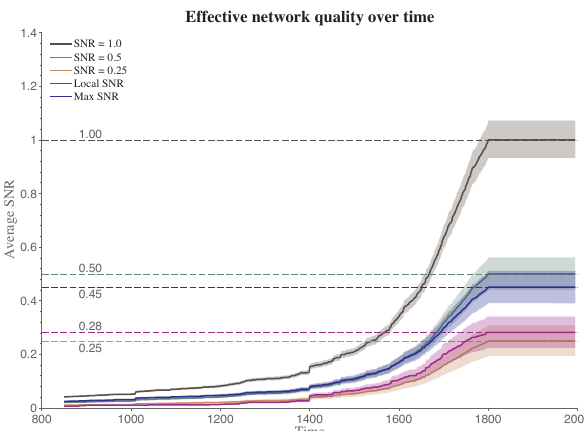
Fig. 4. Effective network quality expressed as SNR (Eq. 2) for ide- alized pseudoproxy networks and observed networks. For the ob- served SNRs, we consider two possible scenarios as described in Sect. 2.1. Shaded areas correspond to the 2.5–97.5 percentile inter- val, providing a complete picture of effective SNR across the 100- member noise ensemble. Dashed lines correspond to the values of SNR for temporally invariant networks. SNR= ∞ is not